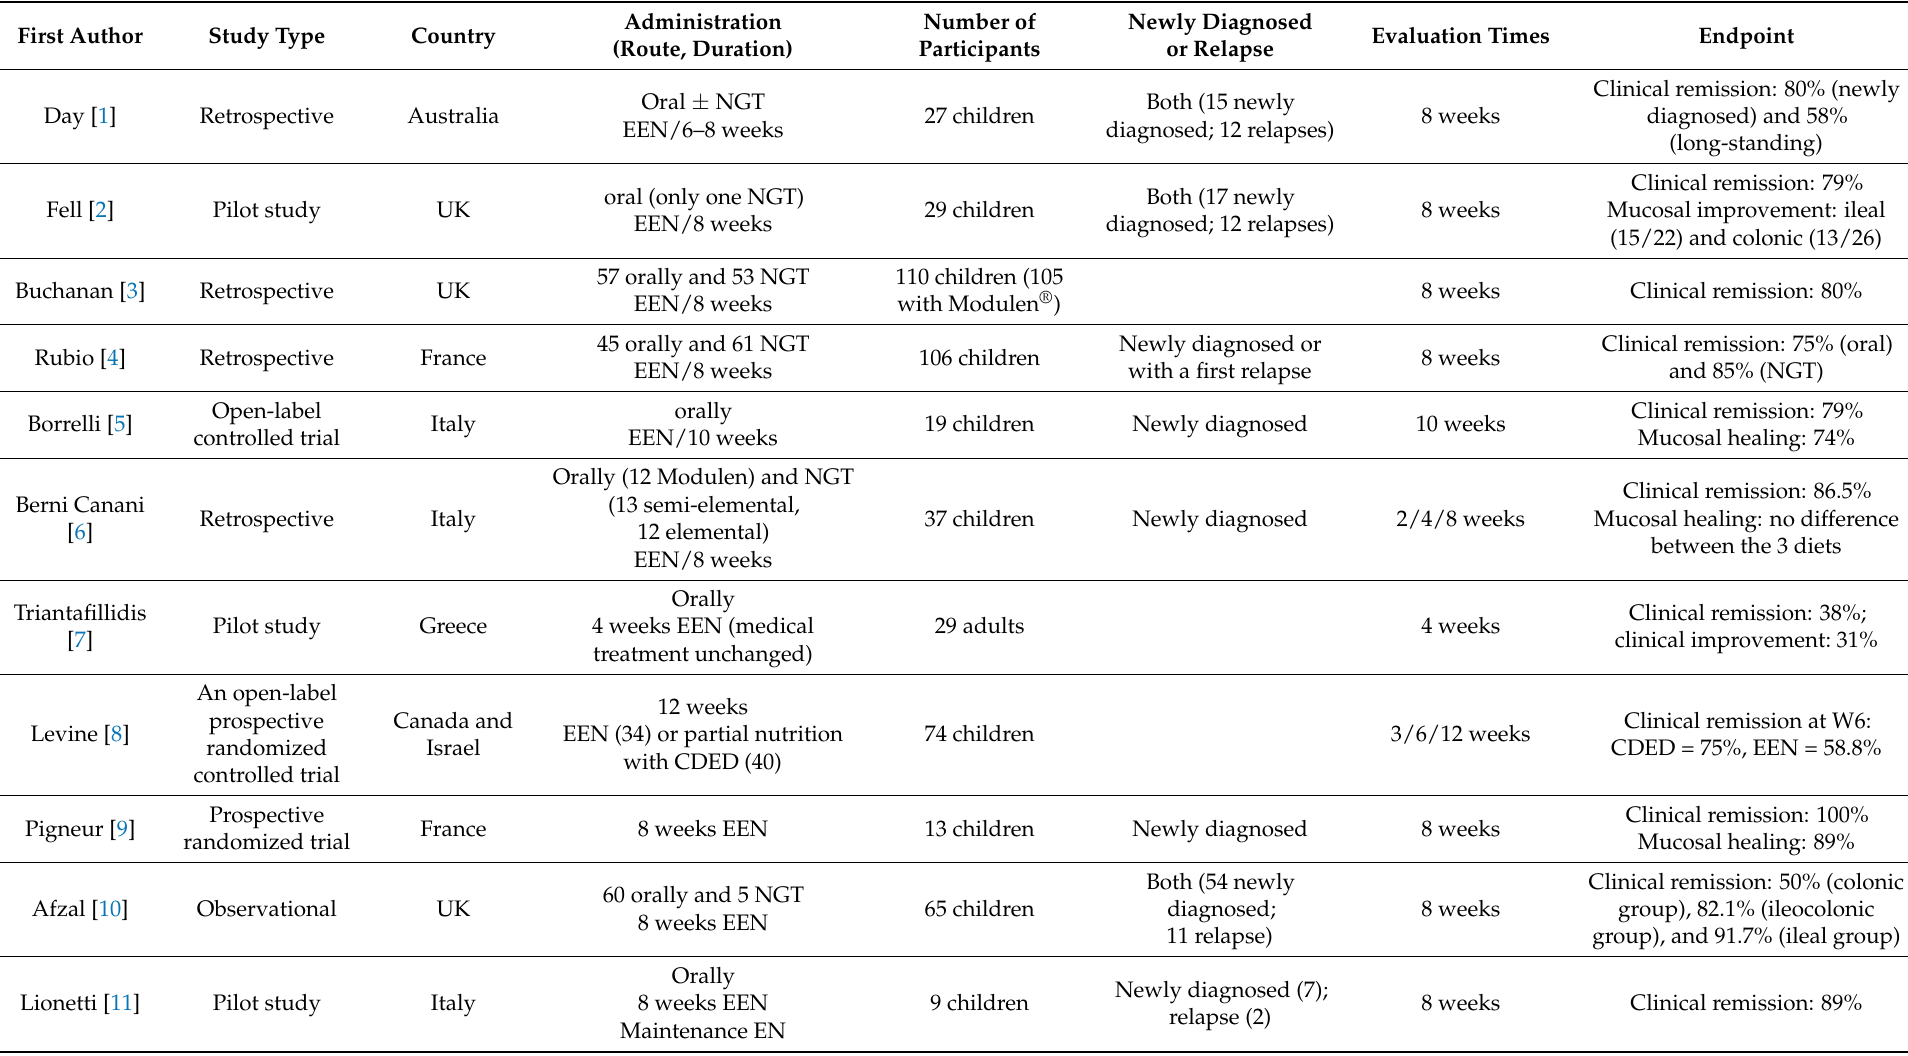
Table 1. Summary of the studies investigating Modulen ®